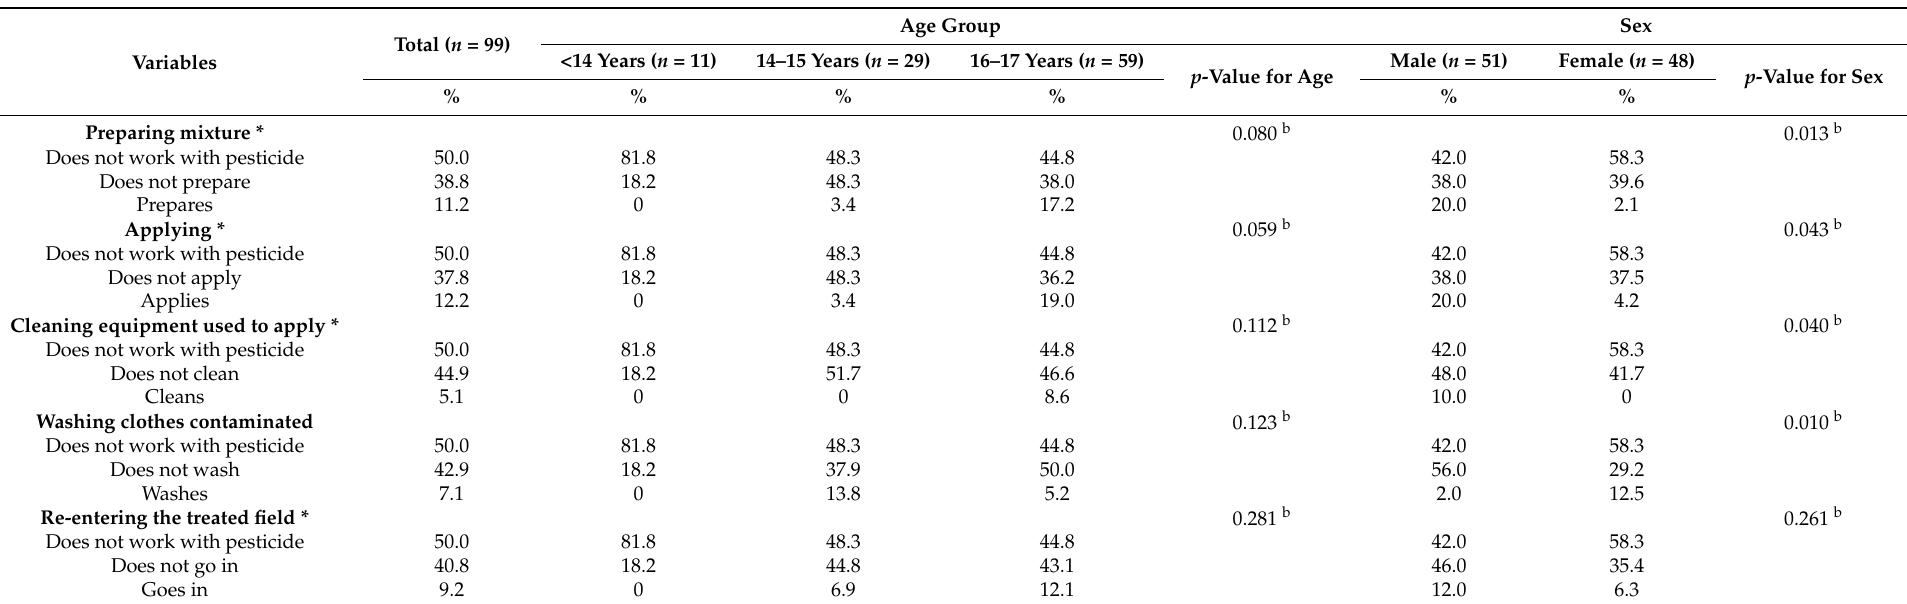
Table 4. Activities involving exposure to pesticides among tobacco farmers who worked with pesticides in the last 12 months. S ã o Lourenço do Sul, Rio Grande do Sul, Brazil, 2011. ( n = 99).